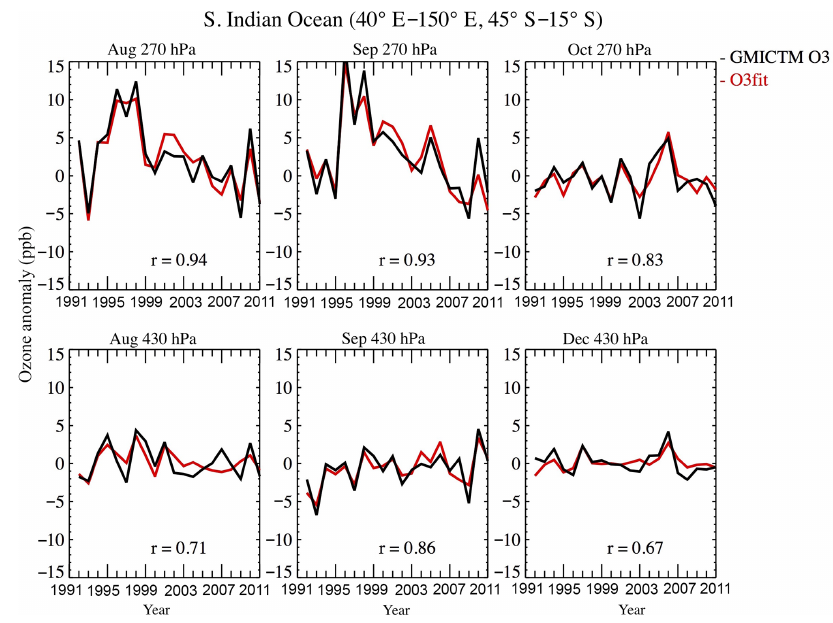
Figure 10. Comparison of the simulated ozone anomalies and the reconstructed ozone anomalies relying on two predictor variables: StratO 3 and EmissO 3 at 270 and 430hPa over the South Indian Ocean region. Three panels show results from August (left), September (middle), and December (right) from 1992 to 2011. Unit for y axis is parts per billion (ppb).